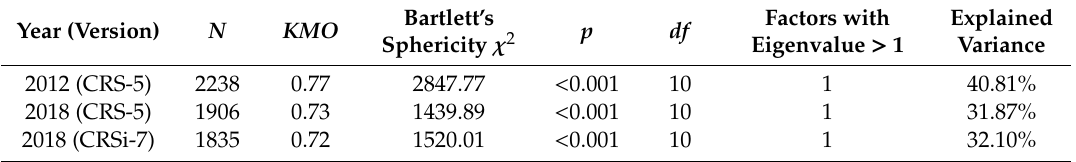
Table 6. Findings of the exploratory factor analyses for CRS-5 and CRSi-7 in 2012 and 2018.